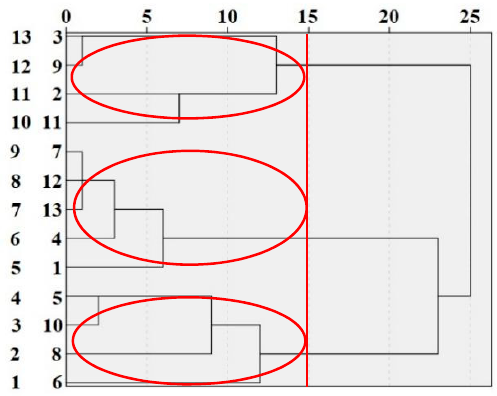
Figure 3. Tree diagram as a result of HCA.